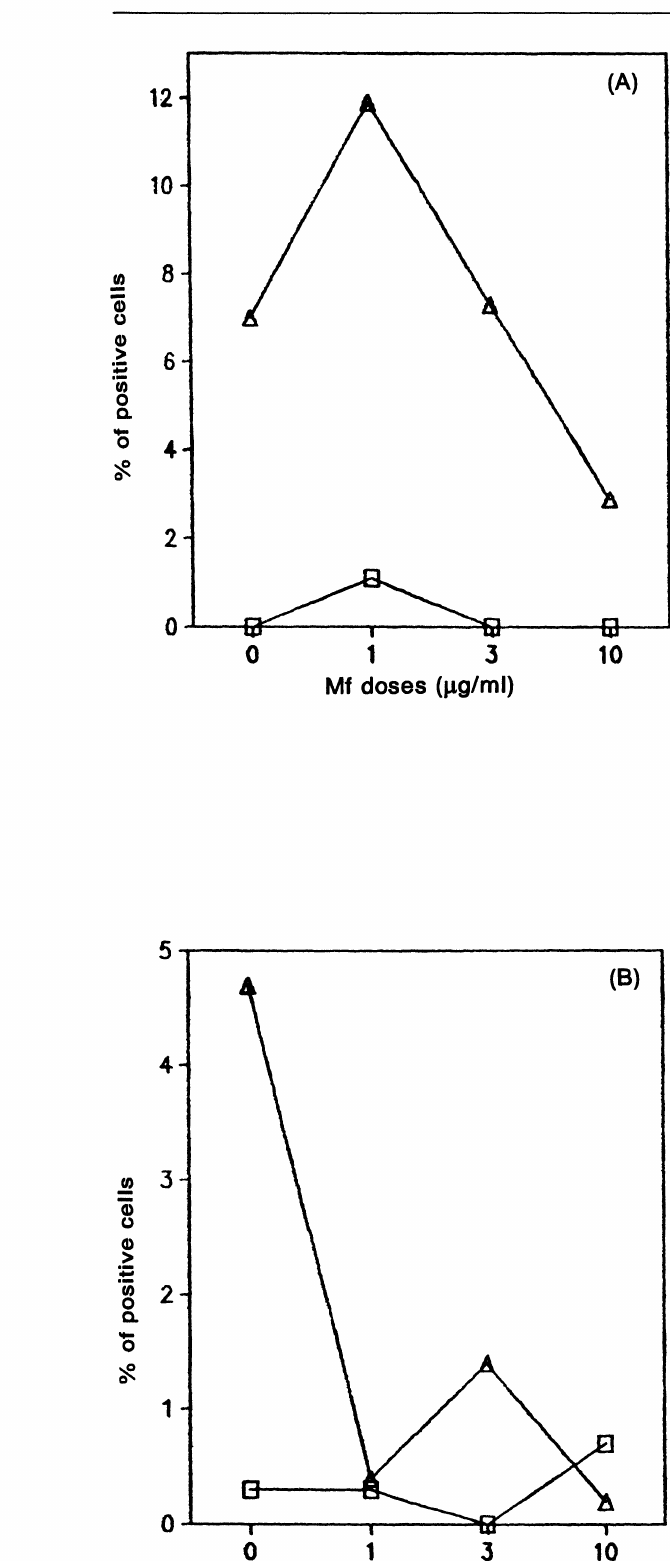
FIG. 5. Flow cytometry analysis of CTL staining with mAbs spe- cific to IL-2R (anti-p55, (F-I)) and IL-2R (anti-p75, (/)) before and after treatment with Mf. The 7-day CTL (A) and 7-day CTL incubated with rlL-2 during 24 h (B) were examined. The number of labelled cells is presented as a percent of total spleen cells